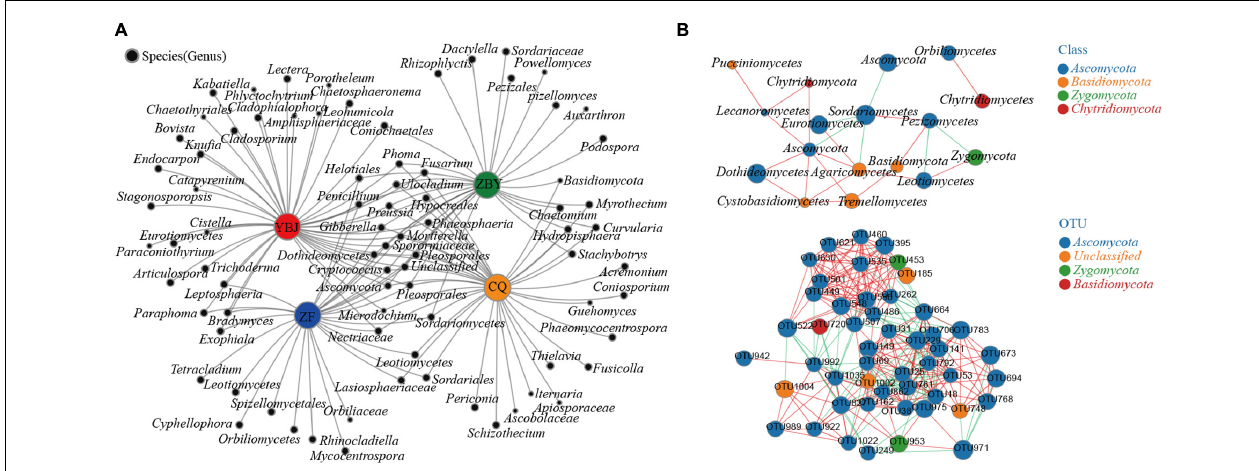
FIGURE 4 | Correlation network of cooccurring and correlation network analysis. (A) Collinear network analysis chart based on the genus level. (B) Correlation network analysis chart based on 35 phyla, showing species with | SpearmanCoef| > 0.8 and P <